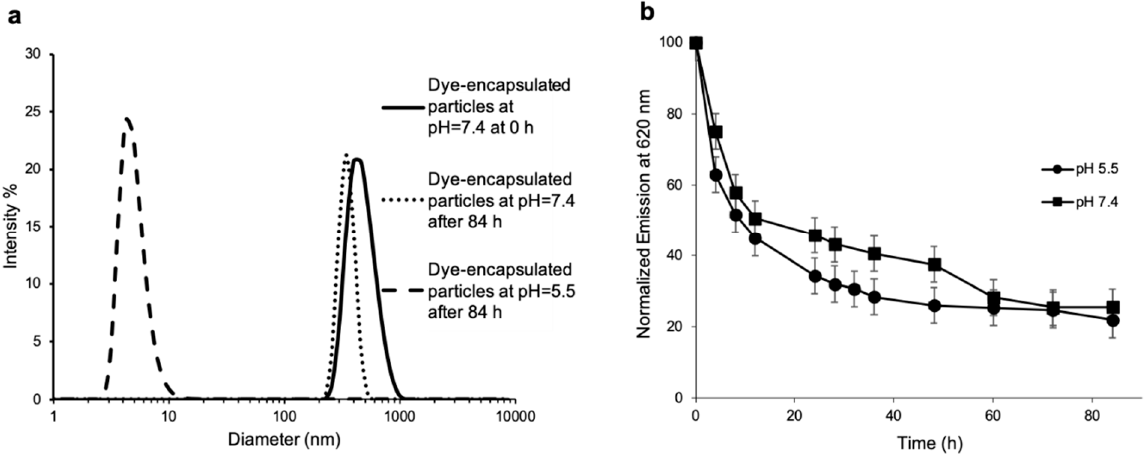
Figure 4. ( a ) DLS data for the Nile red-encapsulated P1 in water at room temperature as well as those incubated at 37 ◦ C in phosphate buffer at pH 7.4 and 5.5 after 84 h. ( b ) The release profile of Nile red from P1 at pH 5.5 and 7.4 at 37 °C.